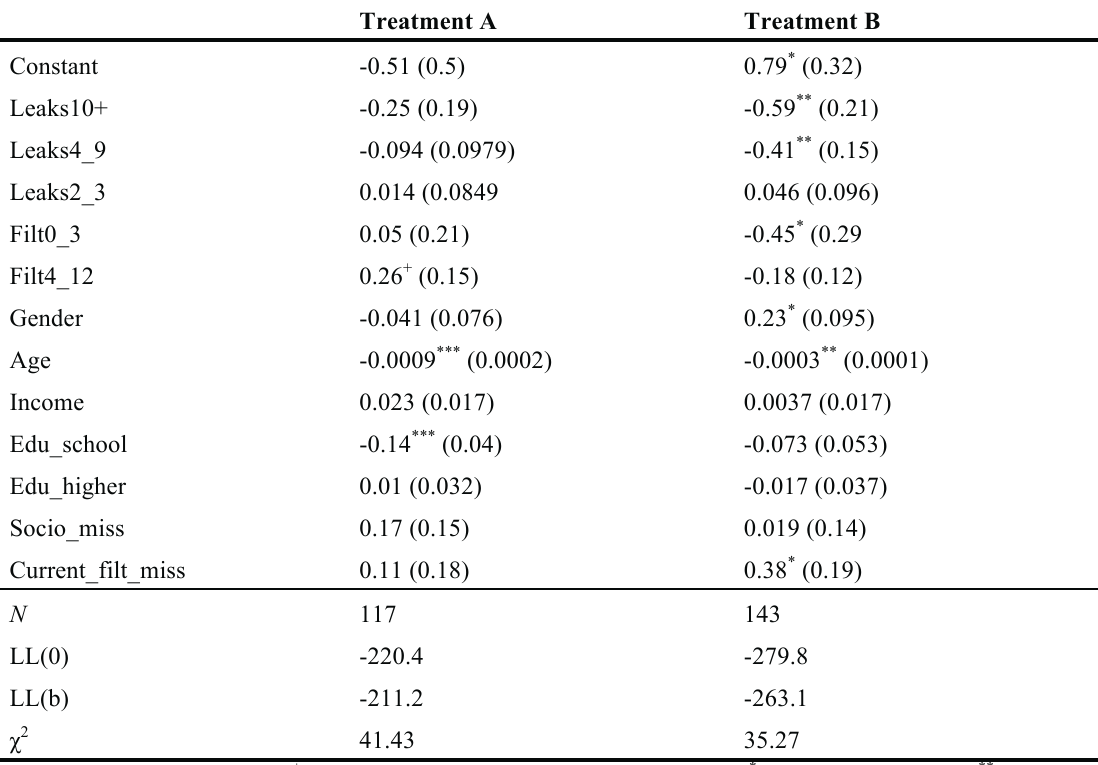
Table 3: Poisson models (dependent variable: Number of SQ choices) Treatment A Treatment